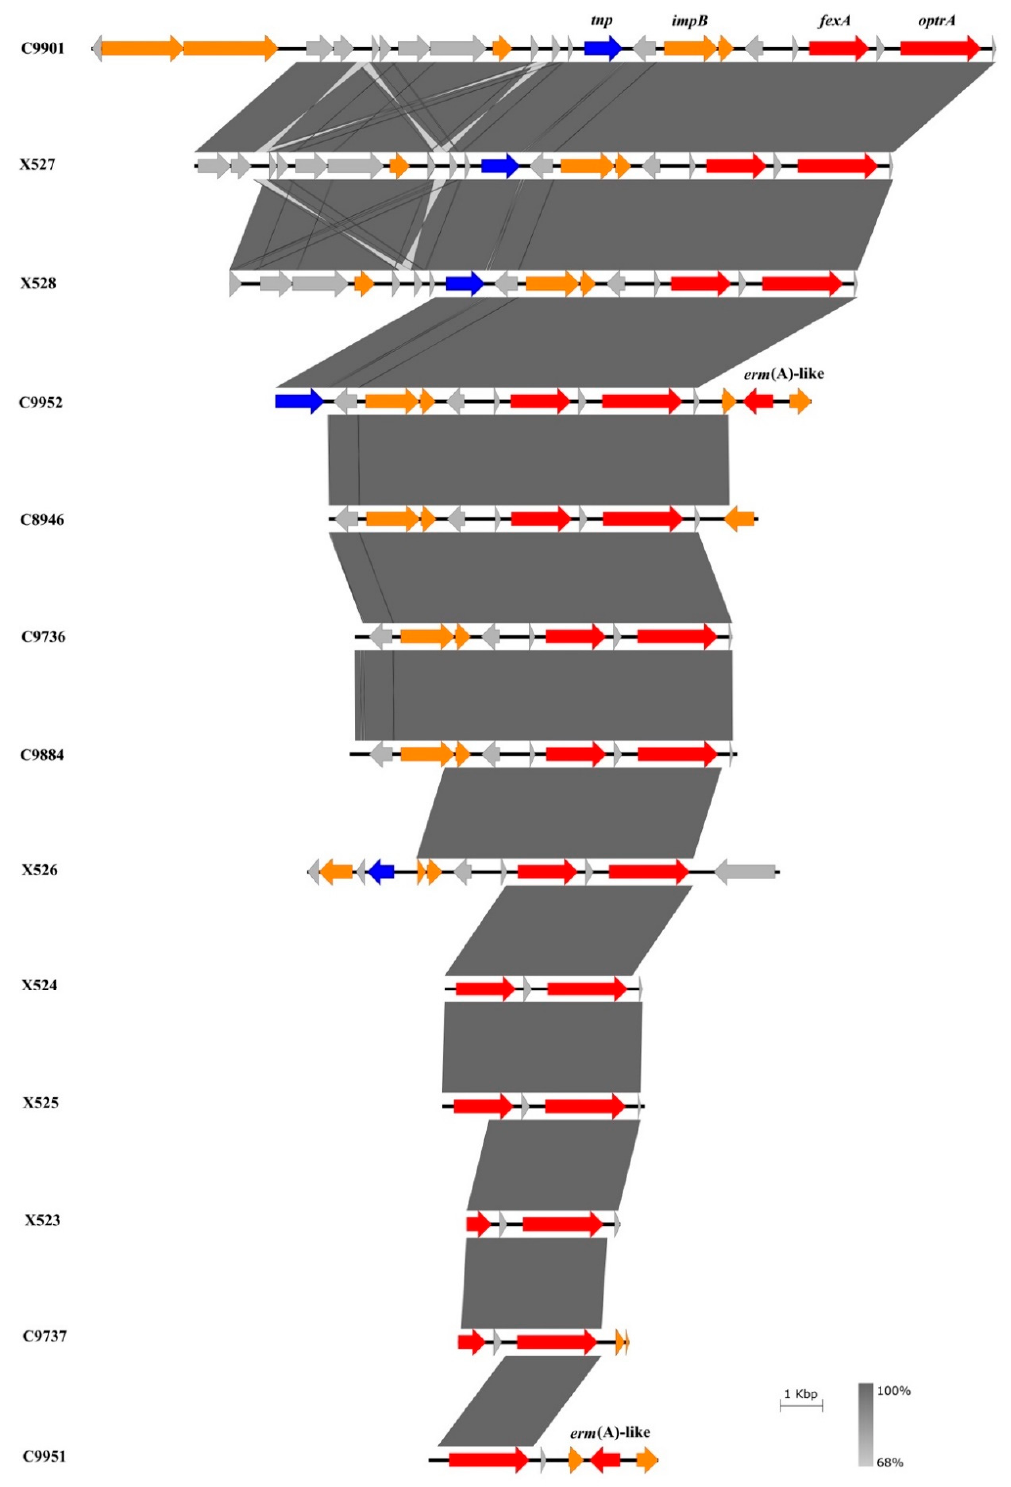
Figure 1. BLAST comparison of the genetic environment of the optrA gene in the 13 clinical LREfs isolates. Coding sequences (CDS) are colored according to their function: red, antimicrobial resistance; blue, recombination and transposition; orange, known function; grey, unknown function. The percentage of identity and scale bar legends are shown on the right.